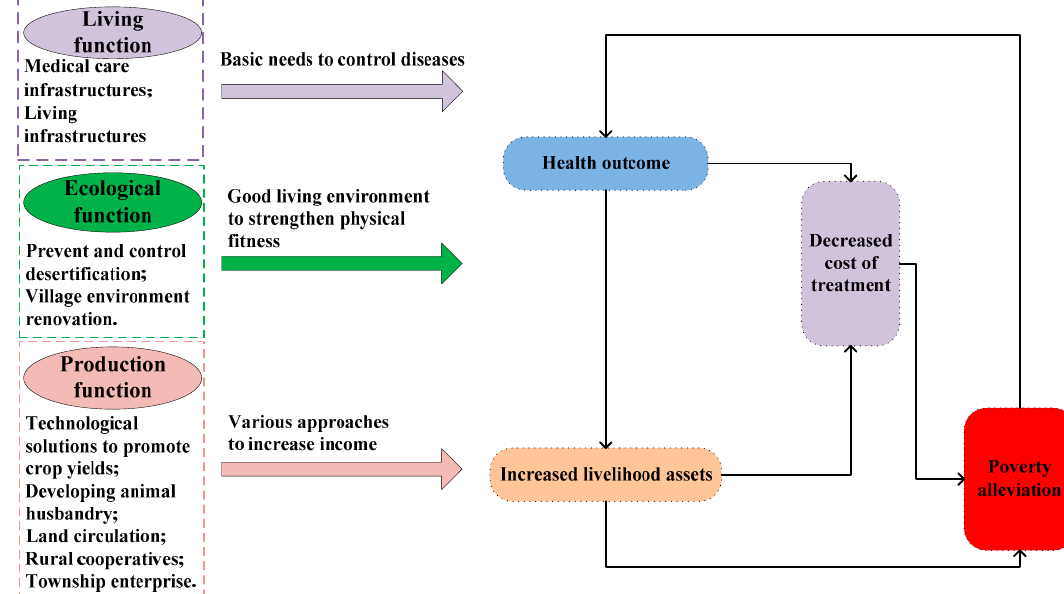
Figure 6. Constructing the “living–production–ecological” space to break the vicious cycle of illness and poverty.